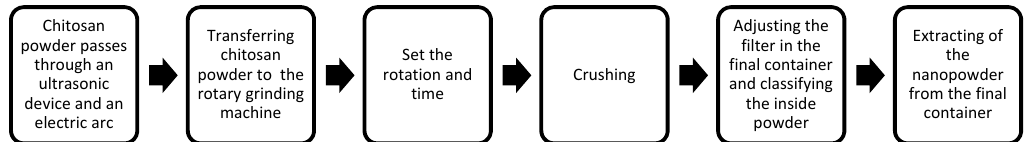
Fig 1. Summary of the chitosan NPs production process by a grinding